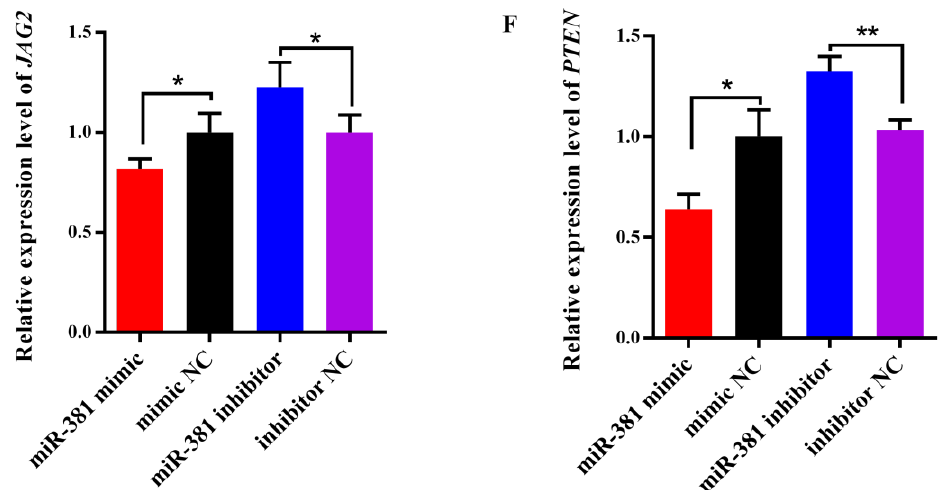
Figure 6. Validation of predicted target genes of miR-381 using dual luciferase reporter assay. ( A ) The binding sequences of miR-381 with the 3′UTR of JAG2 and PTEN in wild-type dual luciferase reporter vectors. ( B ) The complementary sequences of the binding sequences in mutant-type dual